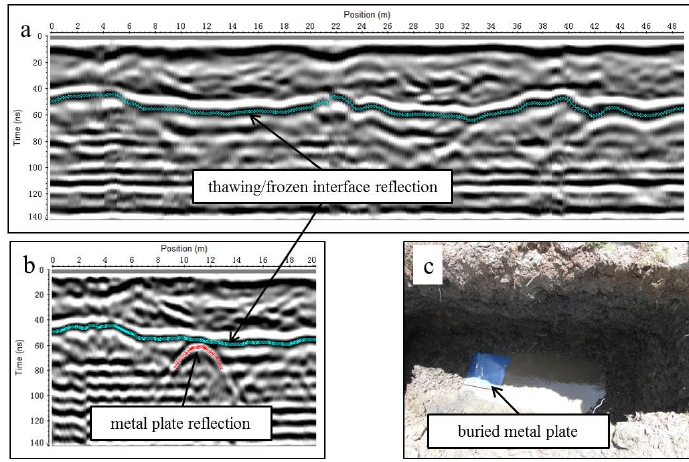
Figure 3. ( a) Common-offset GPR image before the pit was dug; ( b ) common-offset GPR image with the buried metal plate; ( c ) photo of the buried metal plate at the pit’s bottom.